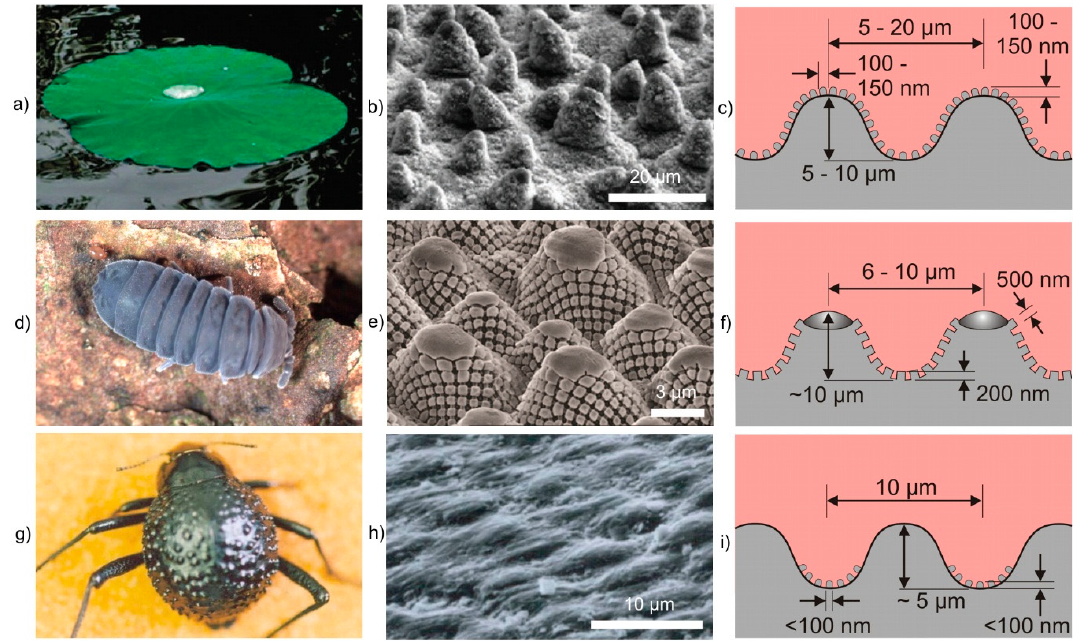
Figure 3. Examples of superhydrophobic surfaces in nature: ( a – c ) leaves of the lotus lower Nelumbo nucifera ; ( d – f ) Tetrodontophora bielanensis springtail cuticle and ( g – i ) Namib dessert beetle Stenocara gracilipes ; ( a , b ) Hensel et al . [33]—Published by The Royal Society of Chemistry; ( d , e ) Adapted by permission from Macmillan Publishers Ltd.: NPG Asia Materials, Hensel et al . [31], copyright 2013;